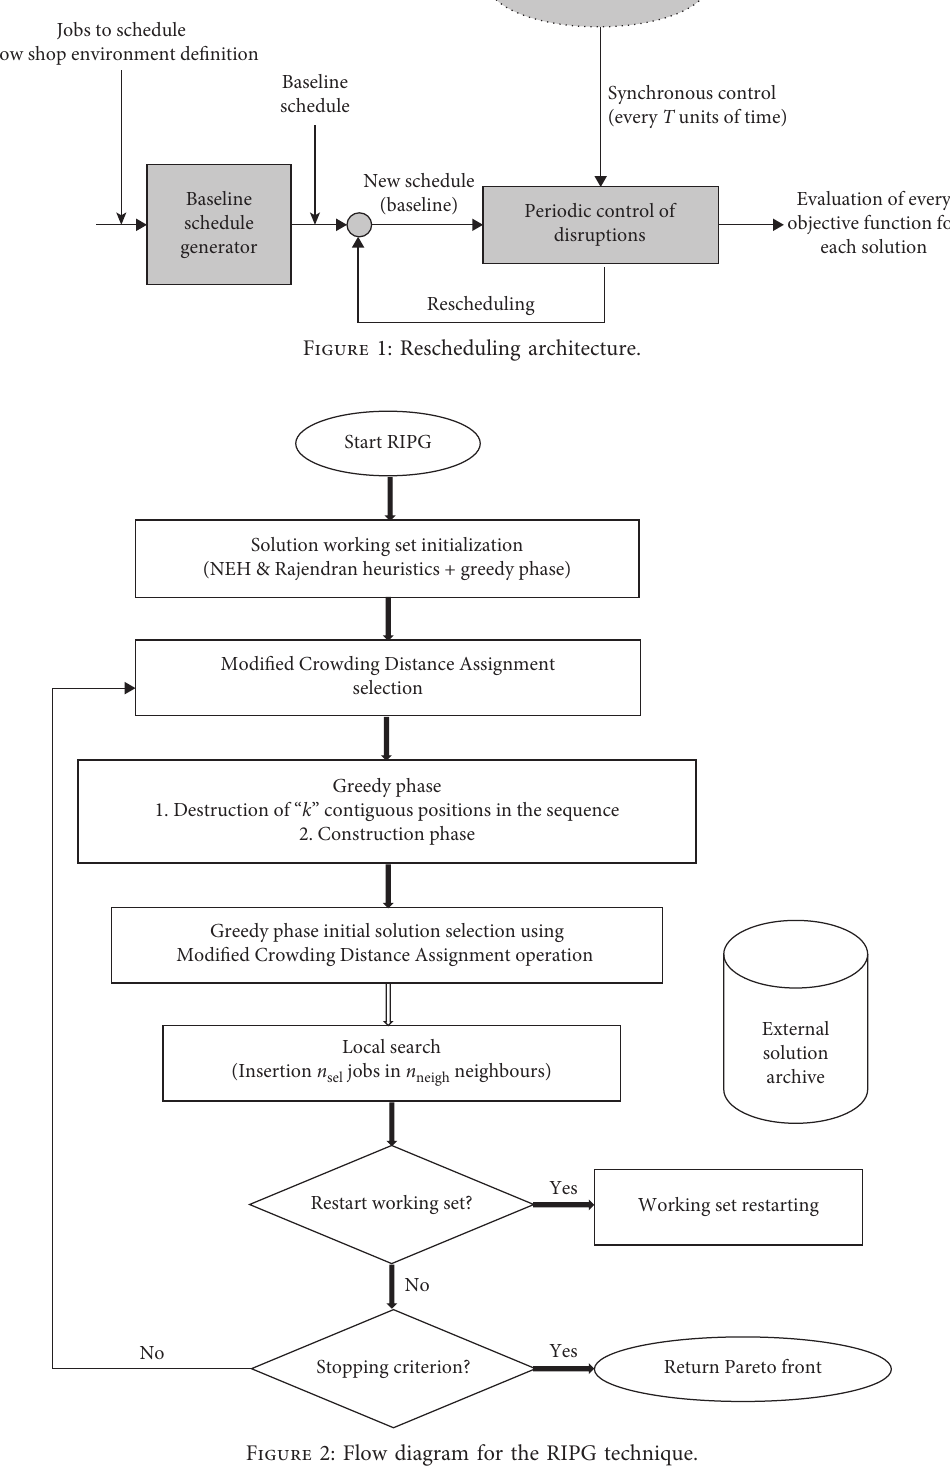
Figure 2: Flow diagram for the RIPG